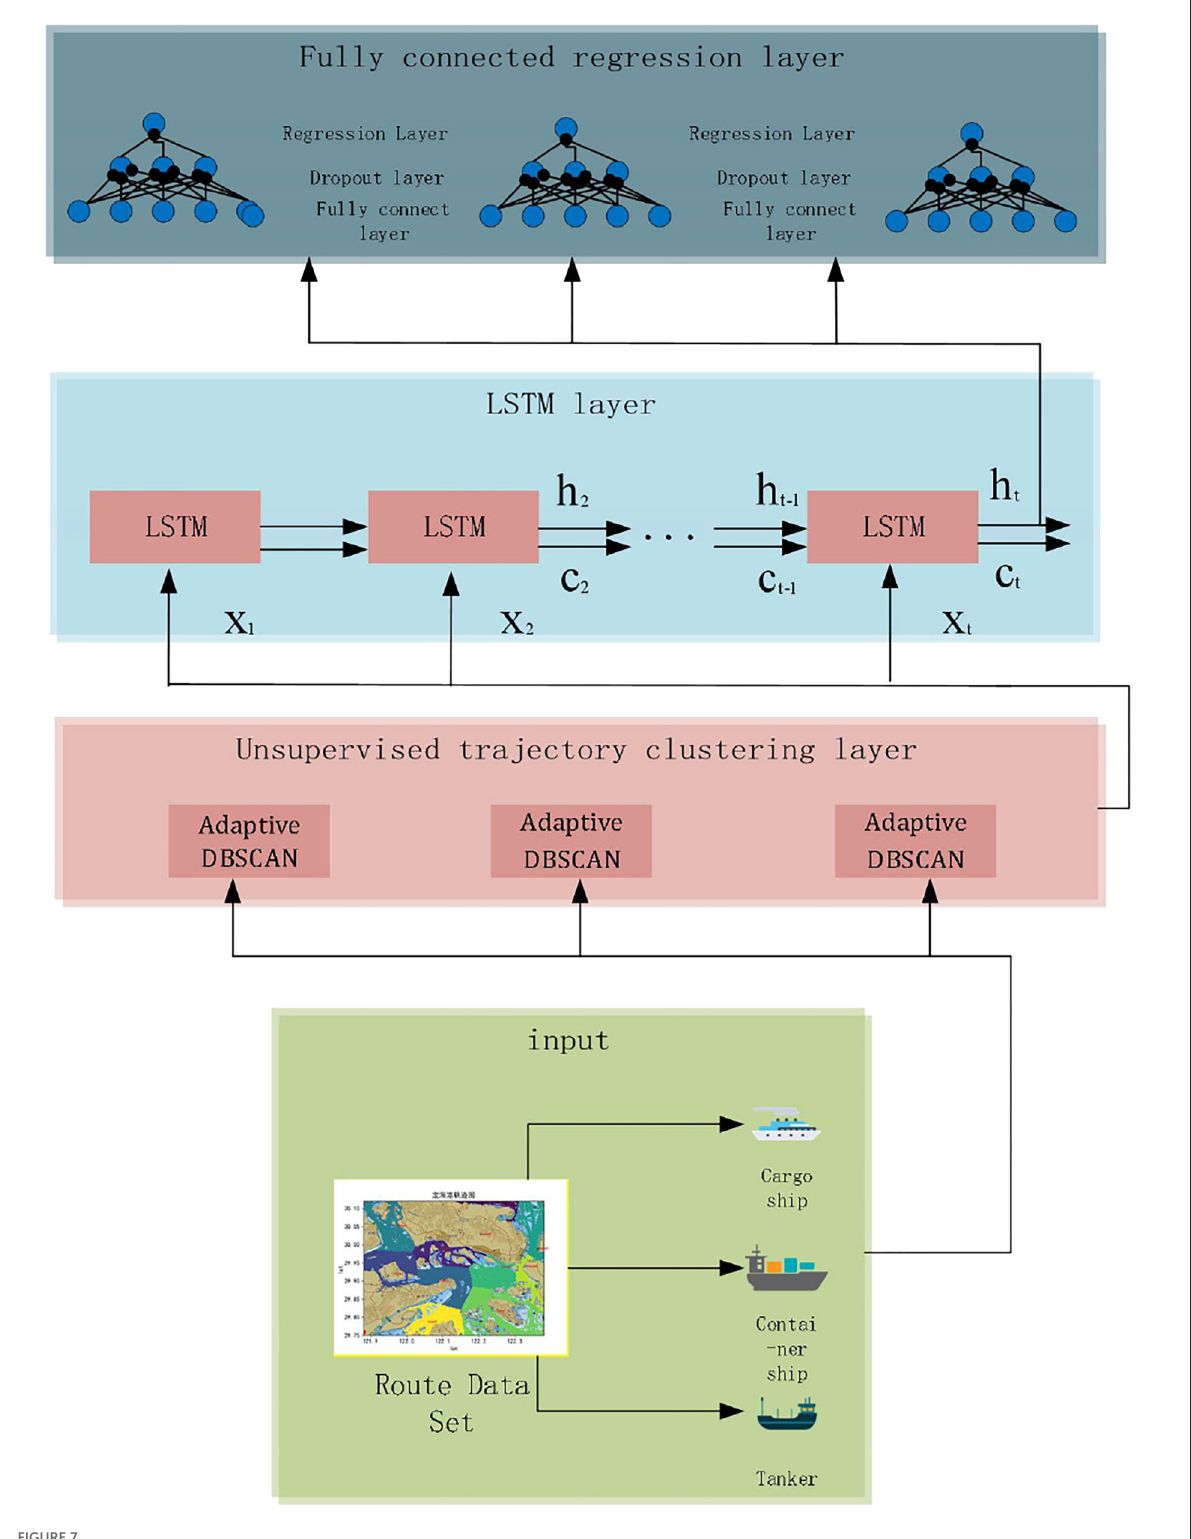
FIGURE7 Adaptive LSTM network